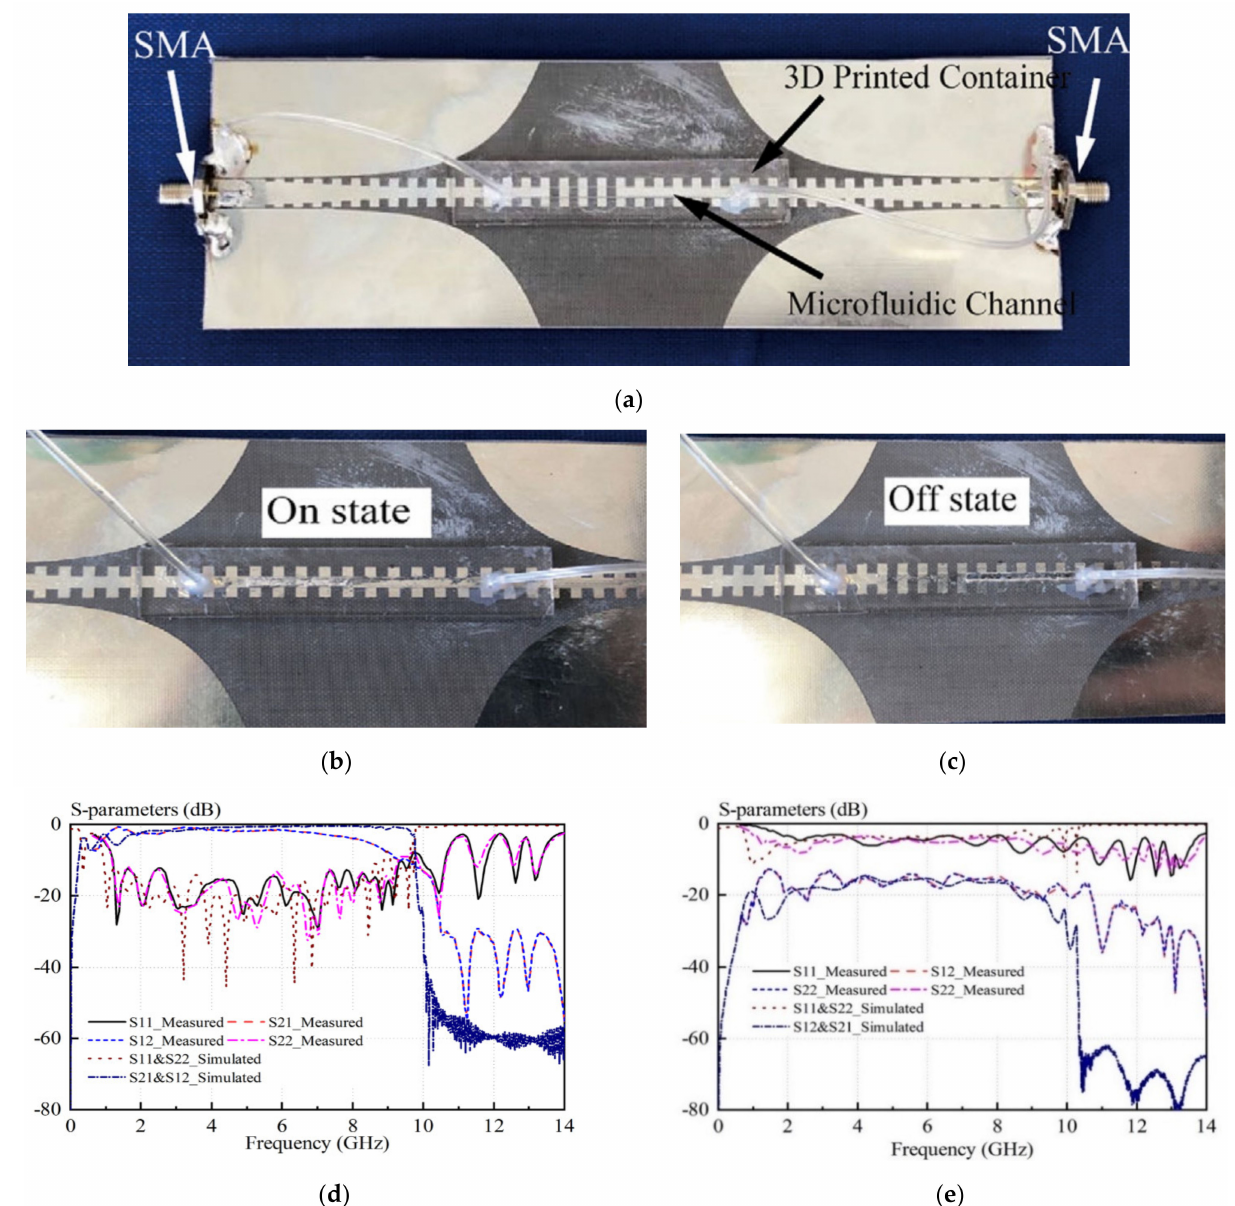
Figure 8. ( a ) Fabricated SPP transmission line. ( b ) SPP-based switch in ON-state by injecting LM to the channel and covering the cut unit cells. ( c ) SPP-based switch in OFF-state by injecting LM to the channel, which cannot cover the cut unit cells. ( d ) Simulated and measured S-parameters of the ON state. ( e ) Simulated and measured S-parameters of the OFF state. Reprinted with permission from Ref. [43]. Copyright 2021 John Wiley and